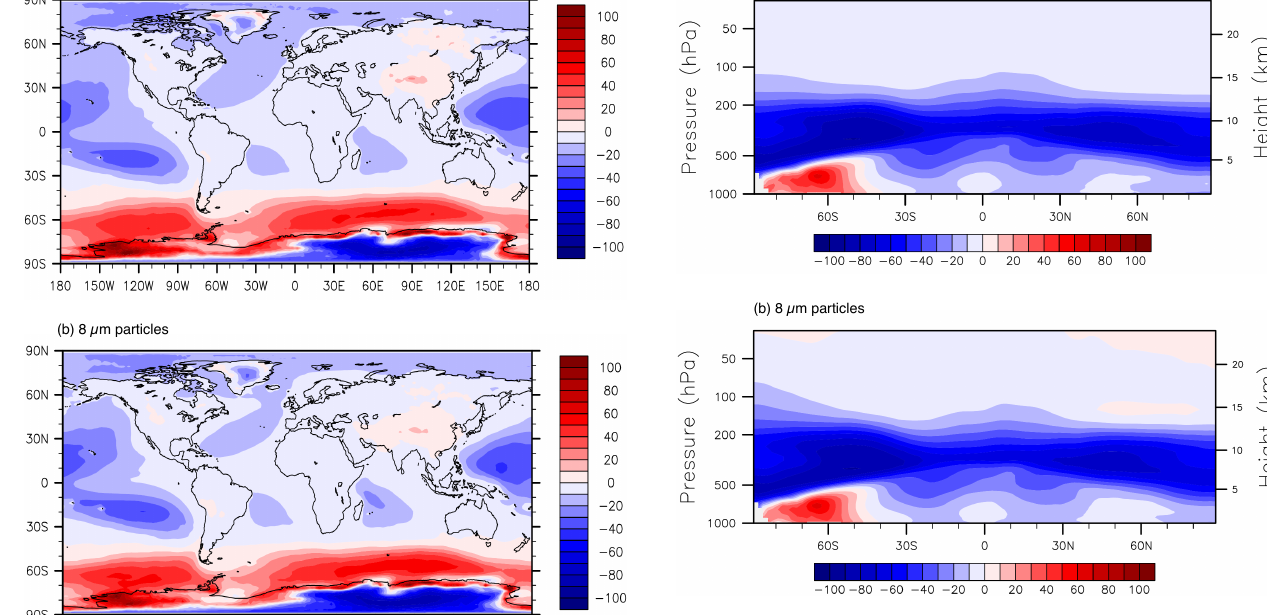
Figure 8. Global model results showing percentage change be- tween IN-Active and IN-Inactive EMAC simulations in zonally av- eraged vertical profiles of annual mean concentrations, with per- centage change being calculated as (IN-Active–IN-Inactive)/IN- Inactive × 100%. (a) 3µm particles; (b) 8µm particles. In all sim- ulations, spores are assumed to be CCN active. IN-Active assumes that particles are removed by ice-phase nucleation at temperatures at and below − 25 ◦ C and above − 35 ◦ C. Emissions were simulated from land surfaces, with the exception of land covered with